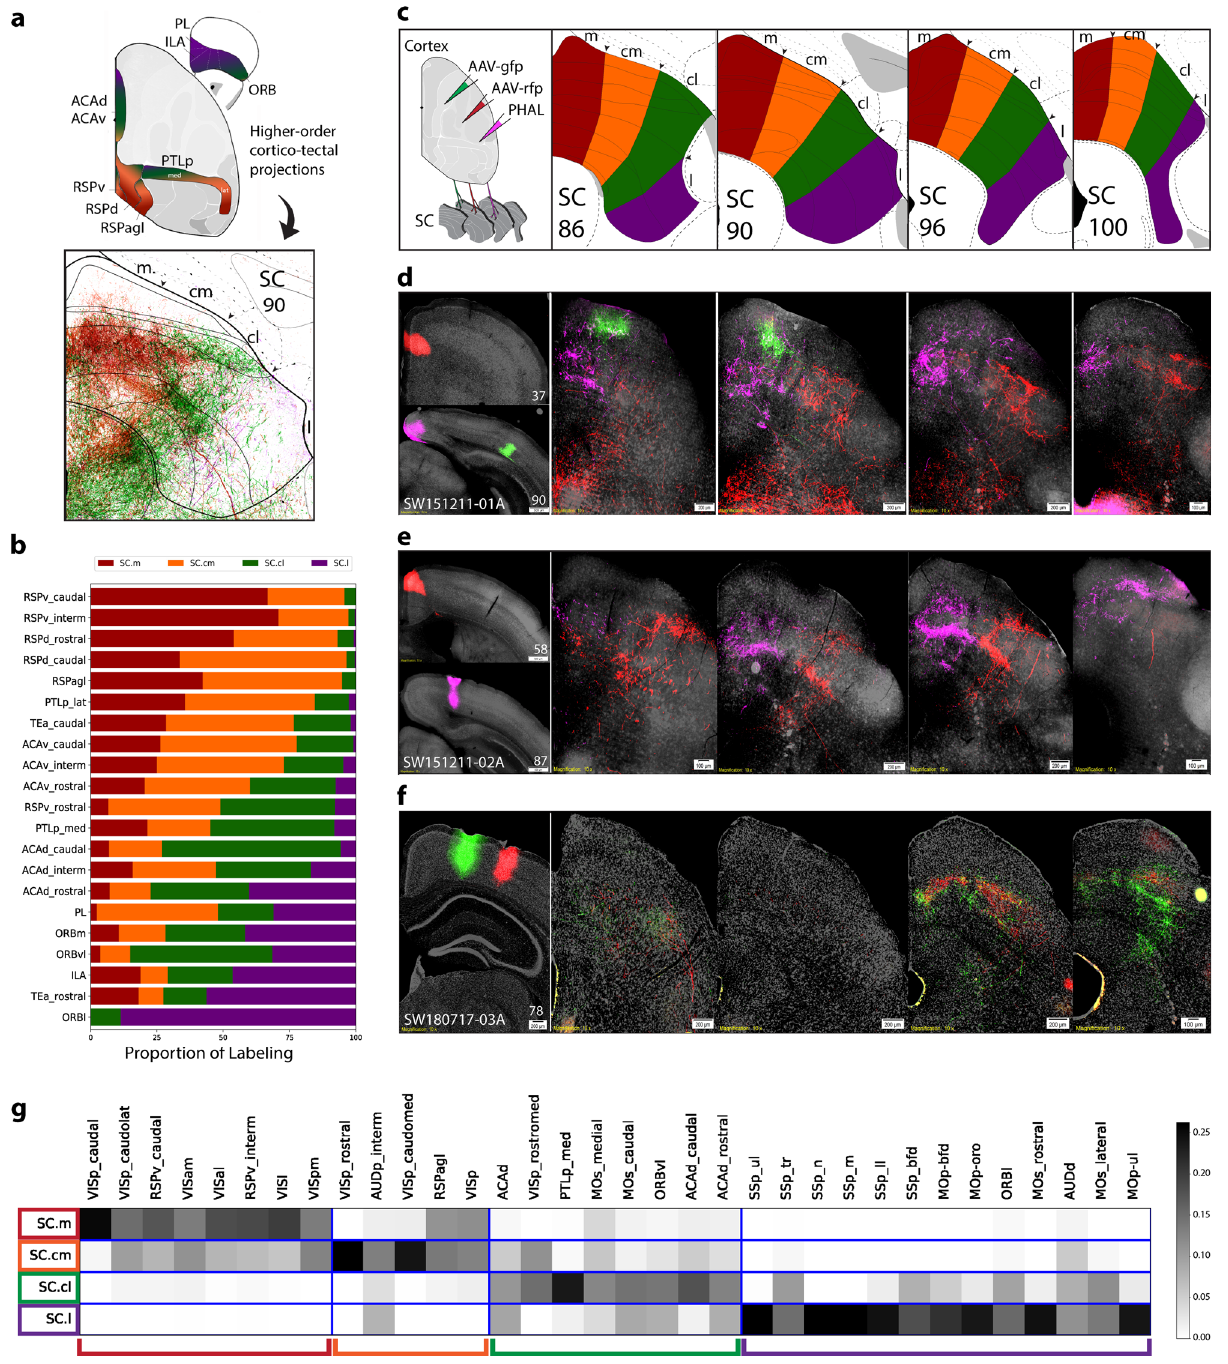
Fig. 3 Distribution of higher-order cortical inputs across SC zones. a Schematic of higher-order association areas part of medial cortico-cortical subnetworks (Zingg et al., 2014). Color-coding is consistent with the SC zones, and represents the topography based on cortico-tectal projection patterns that target distinct zones. Reconstruction is composite of inputs to SC ARA 90. b Stacked bar chart for visualization of proportion of labeling across each SC zone ( x -axis) from each cortical ROI ( y -axis) for each selected ROI. Values represent proportion of pixel density for each individual ROI across each zone ( n = 1 case per row). See Supplementary Table 4 for zone- and layer-speci fi c values. c Schematic of anterograde injection strategy, and custom SC atlas levels. d Raw data panels. VISp, RSPv, and ACAd-rostral projections to SC. e ACAd-interm and VISam projections. f Two PTLp-medial projections projection to caudal SC levels. g Visualization of cortico-tectal modular communities within the SC ( n = 34 cases). Matrices show communities identi fi ed by Louvain analysis of cortical injection ROIs ( y- axis) and SC zones ( x -axis). Edges are shaded according to their connectivity labeling, and boxes along the diagonal re fl ect modular communities identi fi ed. Legend on right side is based on the range of normalized values calculated by the Louvain algorithm. Value 0.25 represents the maximum intensity (black), and value 0 represents the minimum (white). Color-coded brackets below the matrix communities correspond to the same color codes in the SC custom atlas zones. Color-code associations: red (SC.m), orange (SC.cm), green (SC.cl), purple